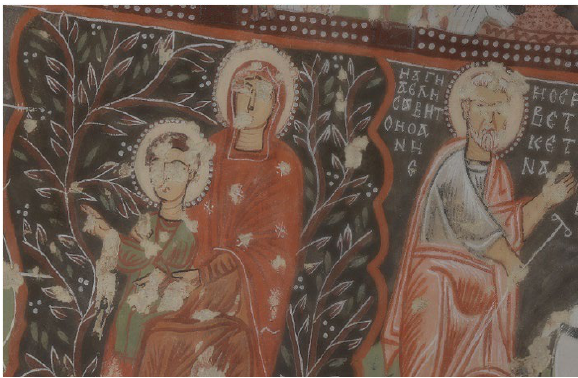
Figure 2. 3D-Modeling of Agios Eustathios Church